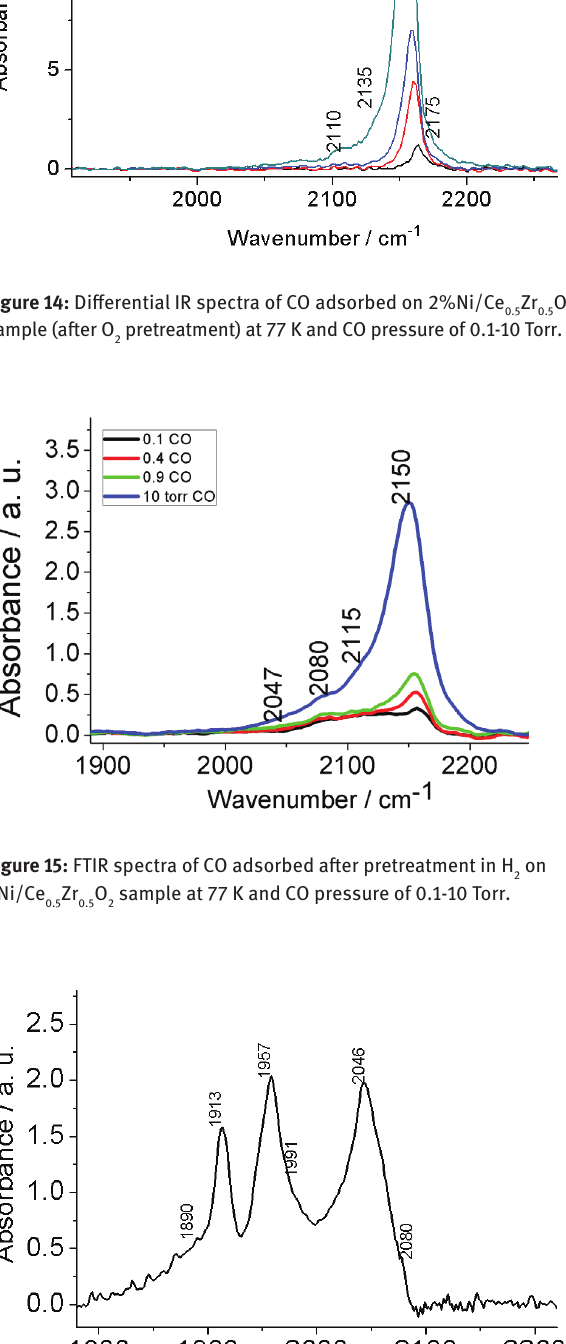
Figure 16: FTIR spectrum of CO adsorbed after pretreatment in H 2Ni/Ce Zr O sample at room temperature and CO pressure of 10 0.5 0.5 2